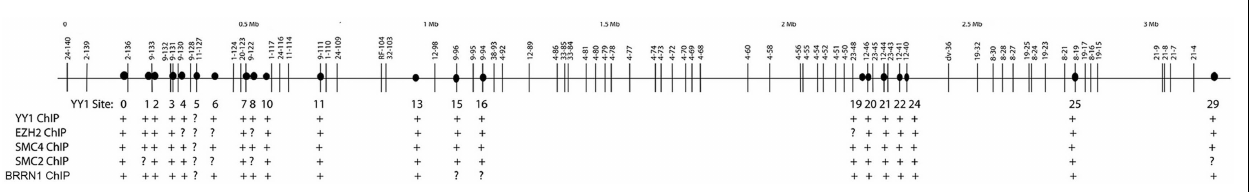
FIGURE 4 | Summary of protein co-localization data across the Ig κ locus . The Ig κ locus is shown in the top panel withV κ genes represented by vertical lines.The identifiedYY1 binding sites are represented by black circles.